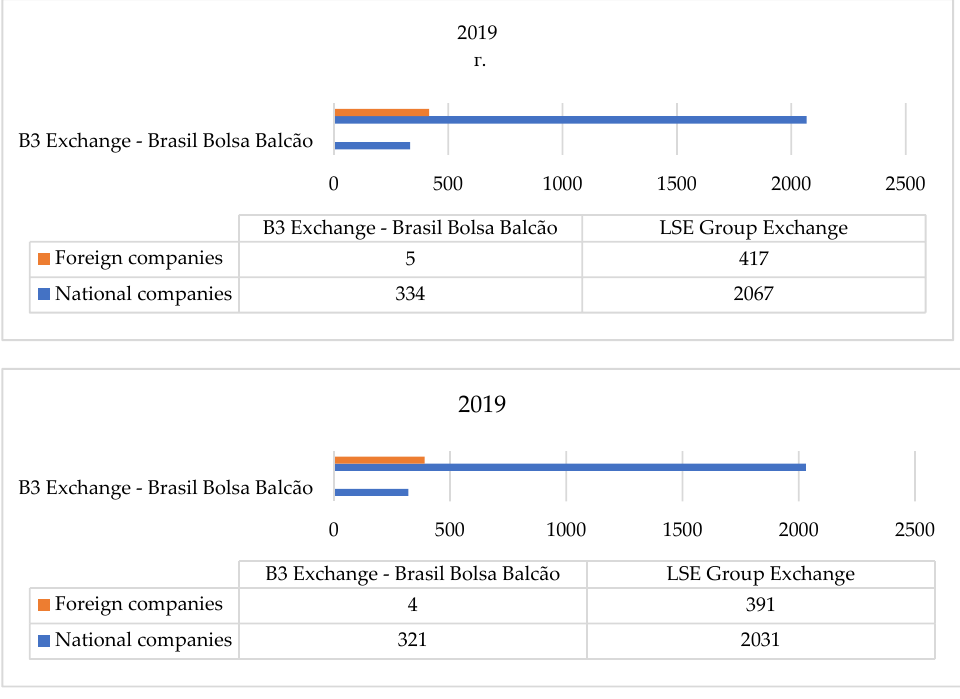
Figure 5. The number of companies listed on the B3 SA-Brasil exchanges, Bolsa, Balc ã o and LSE Group in 2018–2019. Formed by the authors on the basis of The World Federation of Exchanges (2019). It is noticeable that the London Stock Exchange prevails in number, which indicates the scale of stock markets. The percentage of foreign companies is shown in Figure